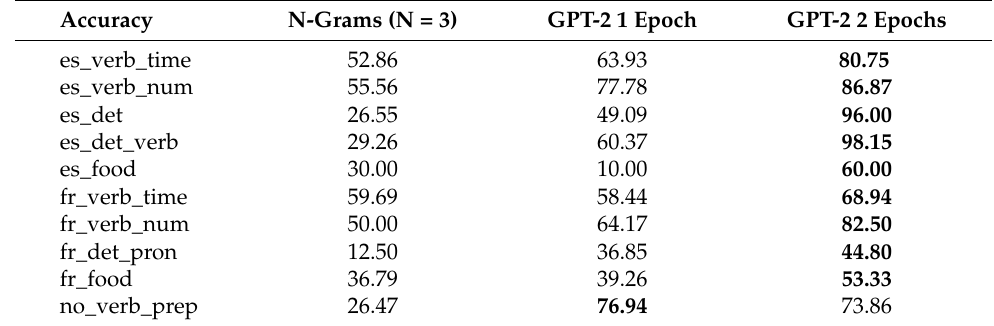
Table A2. Template selection accuracies. The models are different for each language, and the number of candidate templates also differs across tasks. The best result for each task is highlighted in